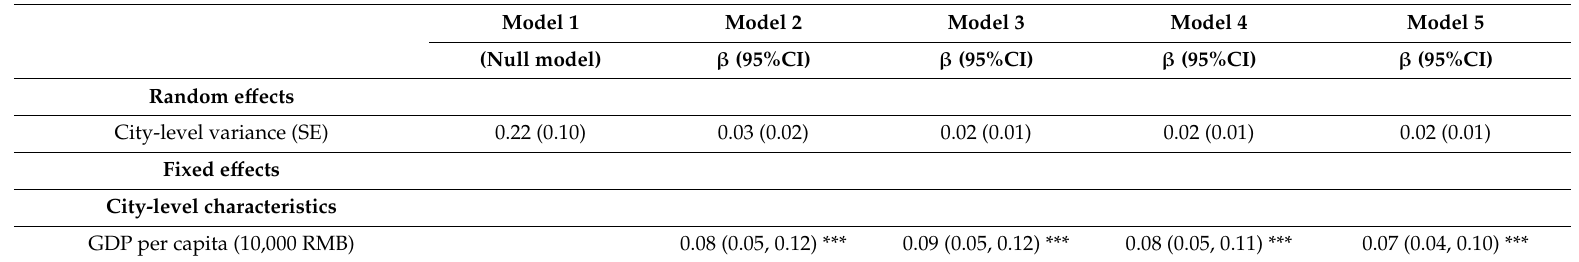
Table 3. Multilevel mixed-e ff ects linear models for factors associated with dental visits ( n =